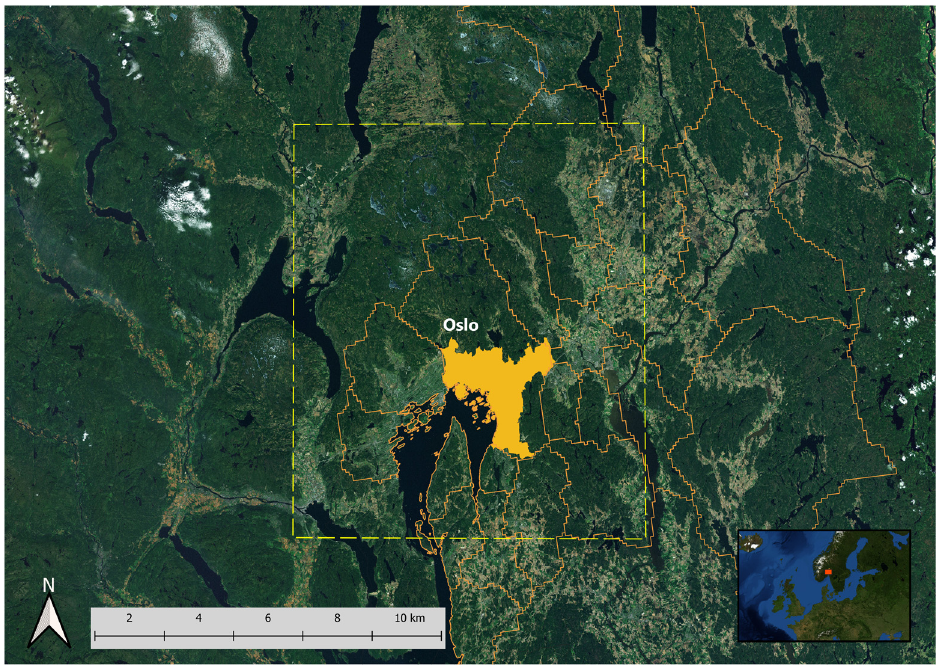
Figure 1. Oslo municipality is the labeled area at center (also shown as red dot in the small embedded map of Europe in the right-hand corner), with its built-up area in solid yellow, whereas neighboring municipalities that make up the Greater Oslo Region are outlined in yellow. The discontinuous line represents the study region of interest